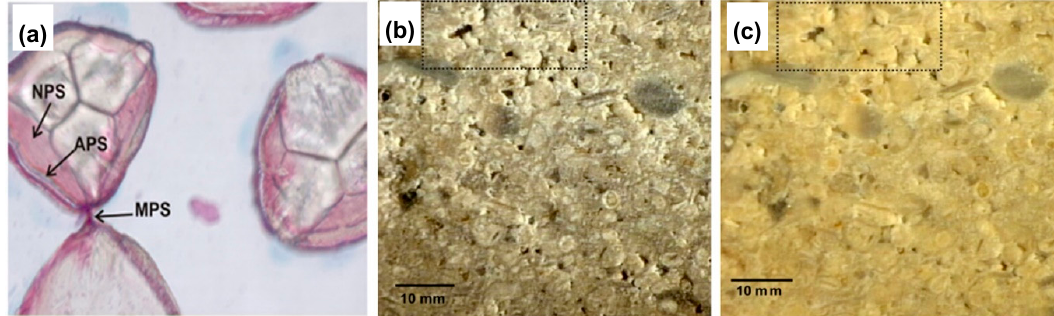
Figure 5. ( a ) Carbonate crystals precipitated by isolate B14 joined by a mixture of acid and neutral polysaccharides. Magnification ×200. NPS, neutral polysaccharides; APS, acid polysaccharides; MPS, mixture of neutral and acid polysaccharides. Isolate D2 on limestone ( b ) before treatment and ( c ) after MICP treatment. Dash line rectangles allow the visual comparison of pore size. Adapted with permission from [72] 2009, American Society for Microbiology.